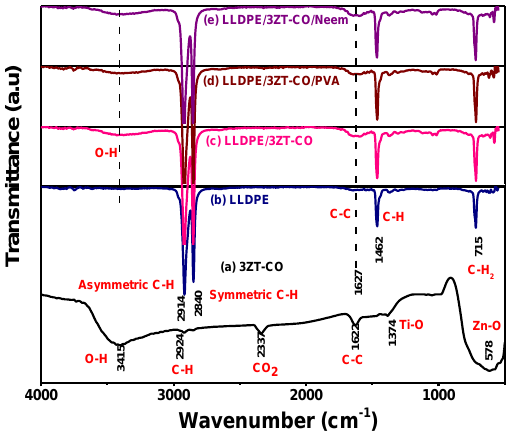
Figure 8. The FTIR spectra of ( a ) 3ZT-CO, ( b ) LLDPE ( c ) LLDPE/3ZT-CO, ( d ) LLDPE/3ZT-CO/PVA, and ( e ) LLDPE/3ZT-CO/Neem.